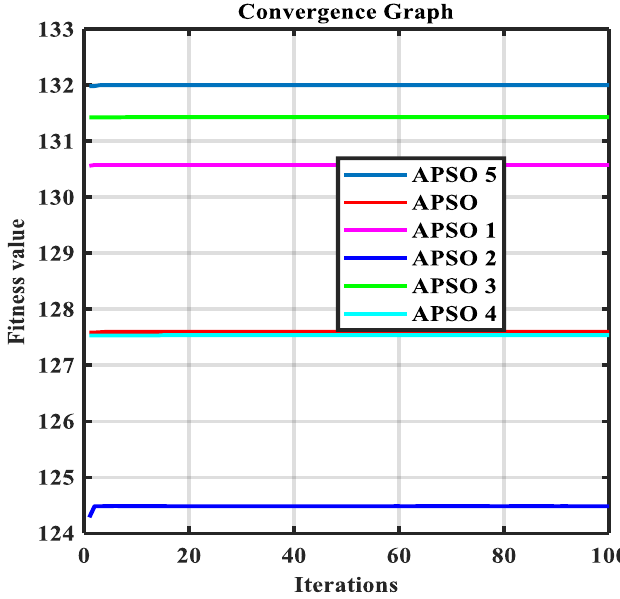
Figure 6. Results comparison between APSO and its variants for 500 PHEVs.